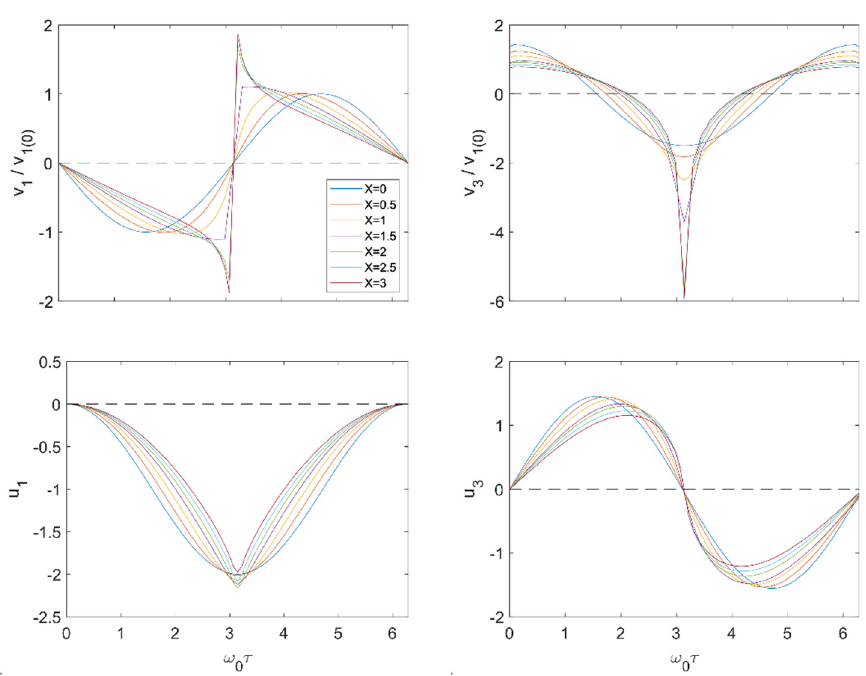
Figure 3. Particle velocity and displacement waveform evolution predicted by Shull et al. model [24] for IN-718: v 1 , v 3 , u 1 , u 3 . The nondimensional abscissa is the product of the initial monochromatic frequency and the retarded time. The nondimensional ordinate is the waveform normalized with respect to the initial amplitude of the v 1 sinusoid. X is propagation distance normalized with respect to shock formation distance.